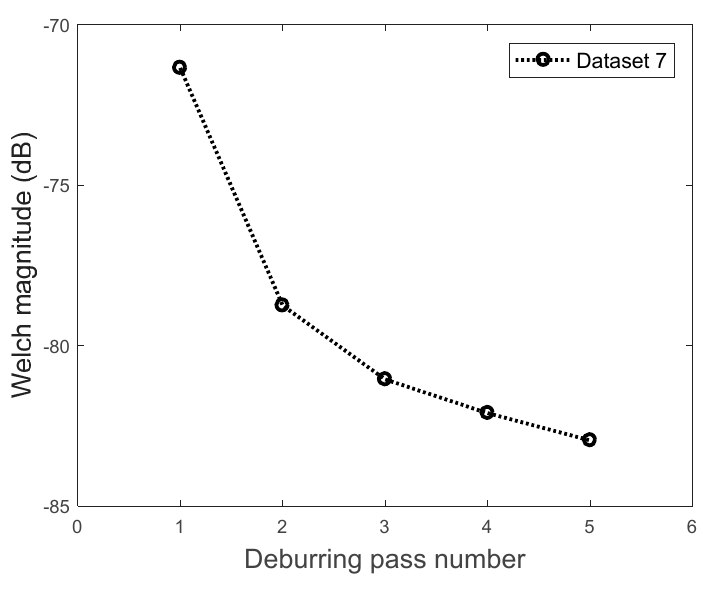
Figure 21. The test dataset.